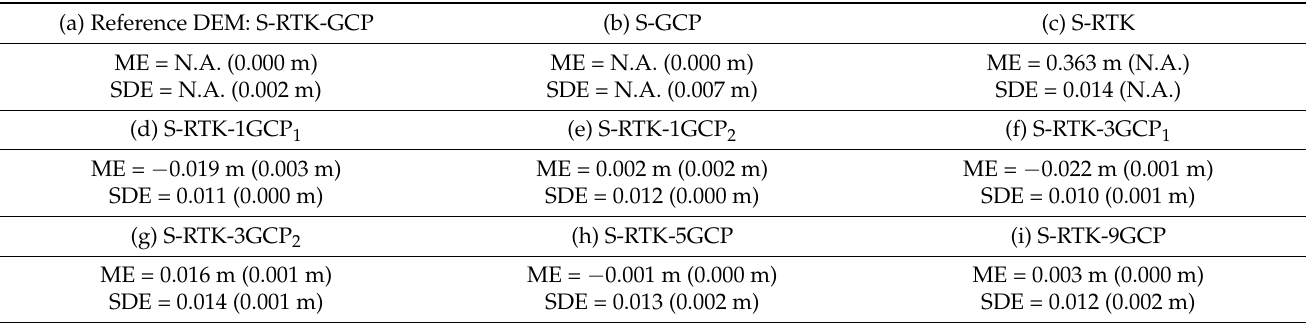
Table 4. Vertical error evaluation for the different scenarios presented in Figure 3 using ground targets (GCPs and ChkPts) measured with RTK-GNSS. The values between brackets correspond to GCP-based error.